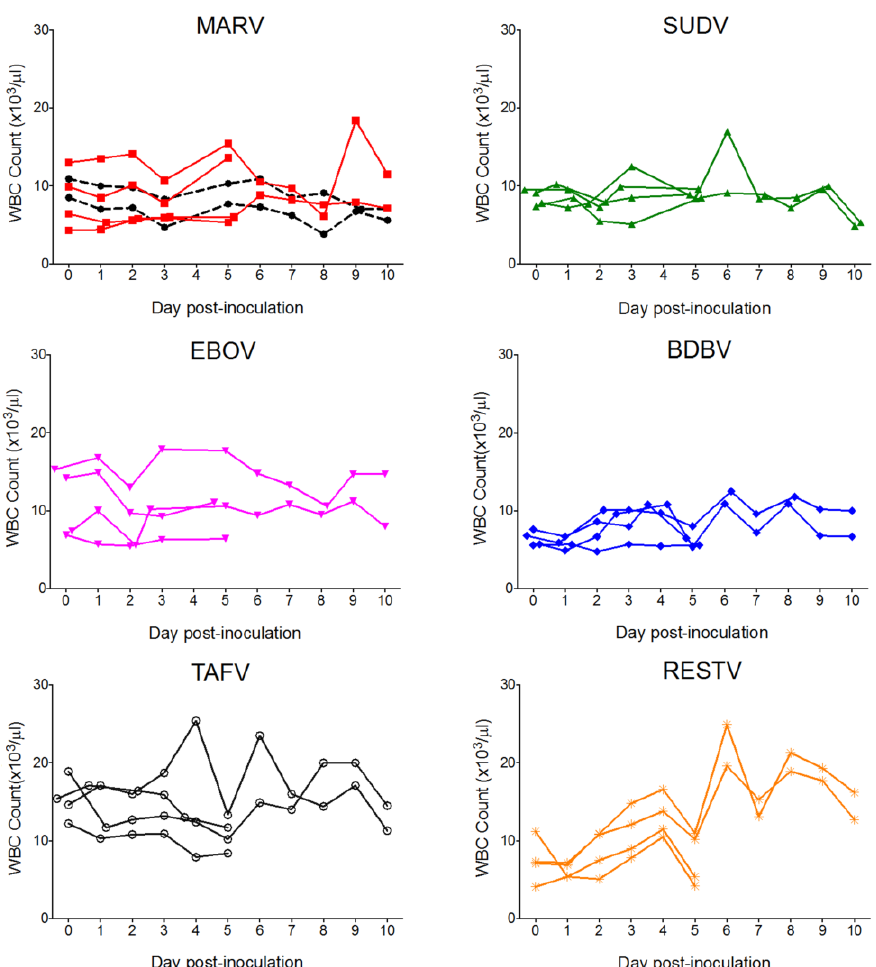
Figure 2. Complete white blood cell (WBC) counts for bats inoculated with six different filoviruses in the pilot study and euthanized at 5 and 10 days post inoculation (DPI). Mock = mock-inoculated controls, MARV = Marburg virus, SUDV = Sudan virus, EBOV = Ebola virus, BDBV = Bundibugyo virus, TAFV = Taï Forest virus, and RESTV = Reston